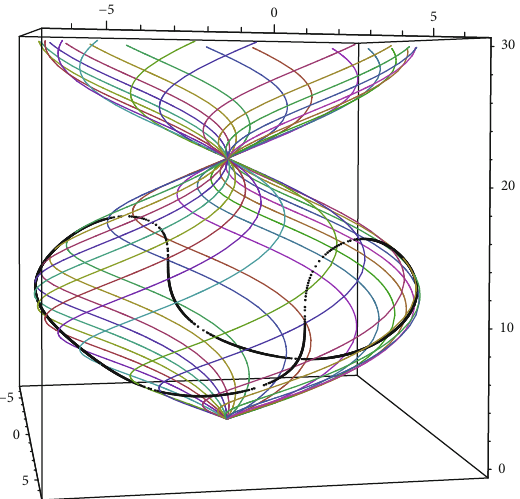
Figure 8: The future light cone of a point at the origin suppressing the ̂ z direction as in Figure 6 showing points along light rays at t = 4 : 2 . We see that the time cut folds over the light cone so that while the cut is one dimensional and smooth, its projection into the ̂ x – ̂ y plane will have